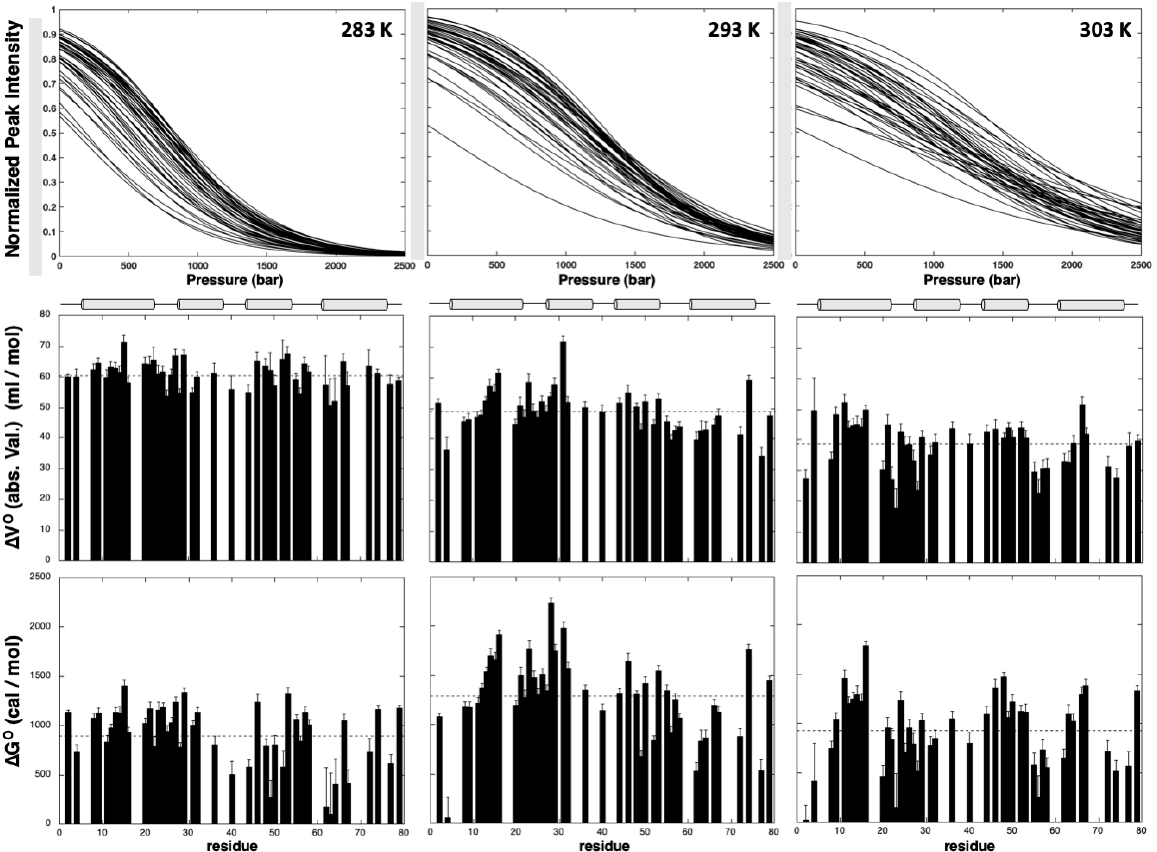
Figure 5 . Steady-state thermodynamic parameters measured for GIPC1-GH2 at 10 °C, 20 °C, and 30 °C (from left to right) from residue-specific pressure denaturation curves. From top to bottom: overlay of the normalized residue-specific dena- turation curves as obtained from the fit of the pressure-dependent sigmoidal decrease of the residue cross-peak intensities in the HSQC spectra with Equation (4); residue-specific values (absolute values) of the apparent volume change of unfold- ing ∆𝑉 (cid:3048)(cid:2868) plotted versus the protein sequence; residue-specific values of the apparent free energy of unfolding ∆𝐺 (cid:3048)(cid:2868) plotted versus the protein sequence. The dashed lines represent the mean values of the measured thermodynamic parameters. The location of the four helices in the protein sequence is schematized with cylinders on top of the graphics. Average values of ∆𝐺 (cid:3048)(cid:2868) calculated for each helix indicate differences in local stability (Supplementary Materials, Figure S5). Interestingly, this local stability depends on the temperature. At 10 °C and 20 °C, helix I and II appear slightly more stable than helix III and IV, helix II being the most stable at 20 °C whereas it has a similar stability as helix I at 10 °C. At 30 °C, the highest values of ∆𝐺 (cid:3048) (cid:2868) are found in helix I and III. Importantly, the local thermal stability measured for each helix follows the thermal stability of the whole domain, with a maximum observed at 20 °C. Likewise, a similar decrease with tempera- ture is observed for average ∆𝑉 (cid:3048) (cid:2868) values calculated for each helix and for the average value calculated over the whole structure, but without any significant variations between the four helices. Information brought by normalized residue-specific denaturation curves has been used to track and to characterize possible intermediates in the folding pathway of GIPC1- GH2 [6,8]. Thus, at a given pressure, the value of 1 measured for a given cross-peak ( I = I f = 1; Equation (4)) is associated with a probability 𝑃 (cid:3036) of 1 (100%) to find the corresponding